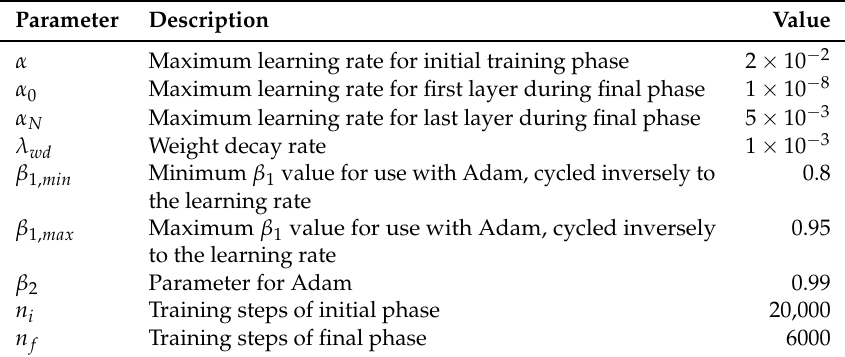
Table 2. Hyperparameters used for training the